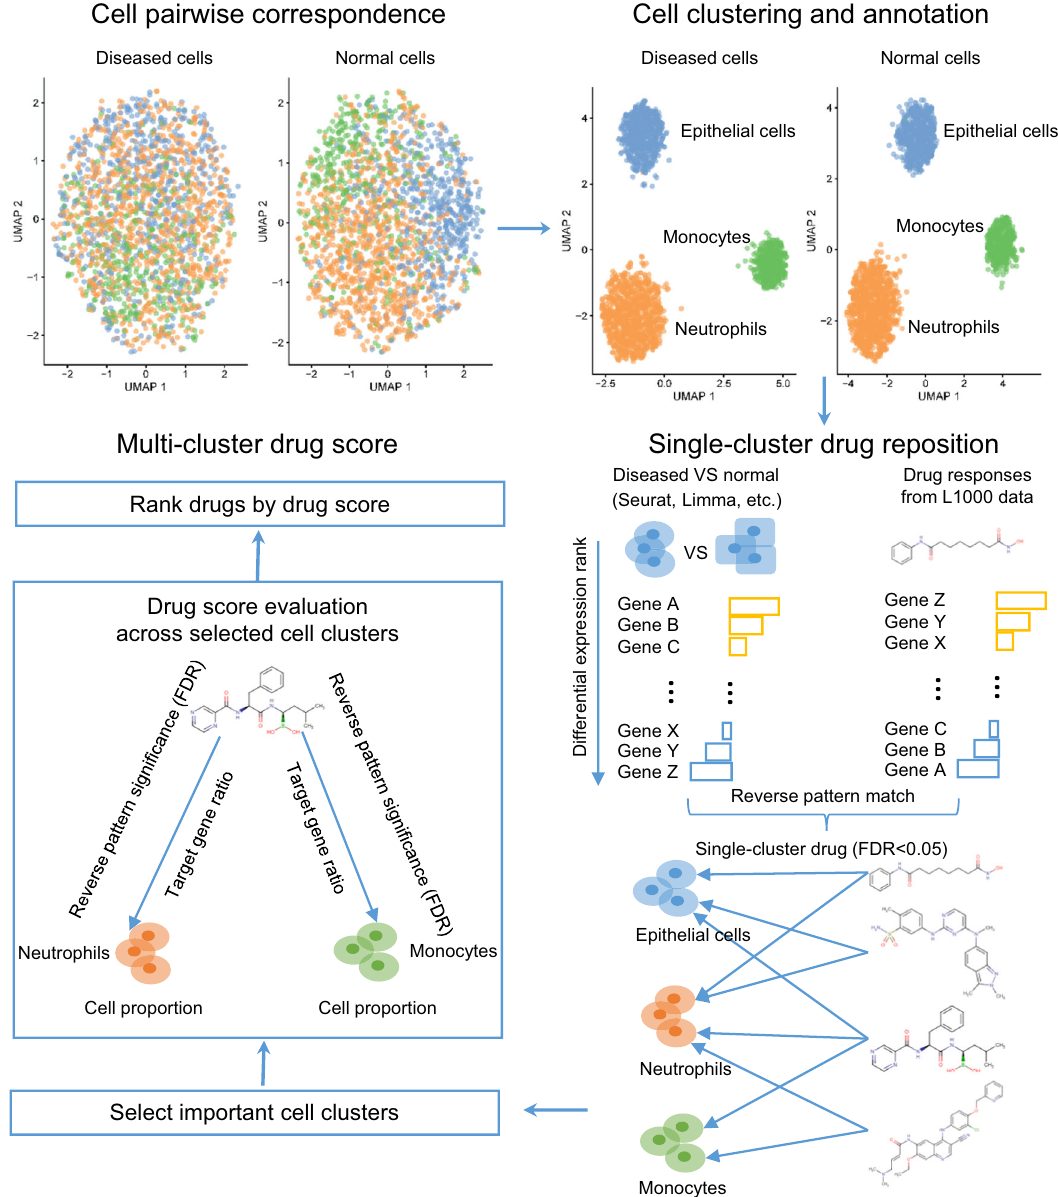
Fig.1|Thework fl owoftheASGARDdrugrepurposingpipeline. Thework fl owof the ASGARD pipeline. Diseased and normal cells are paired according to “ anchor ” genes that are expressed consistently between the two types of cells. The differ- entially expressed (DE) genes are identi fi ed between diseased and normal cells, either within a cluster or within a cell type. Using the consistent DE genes as the